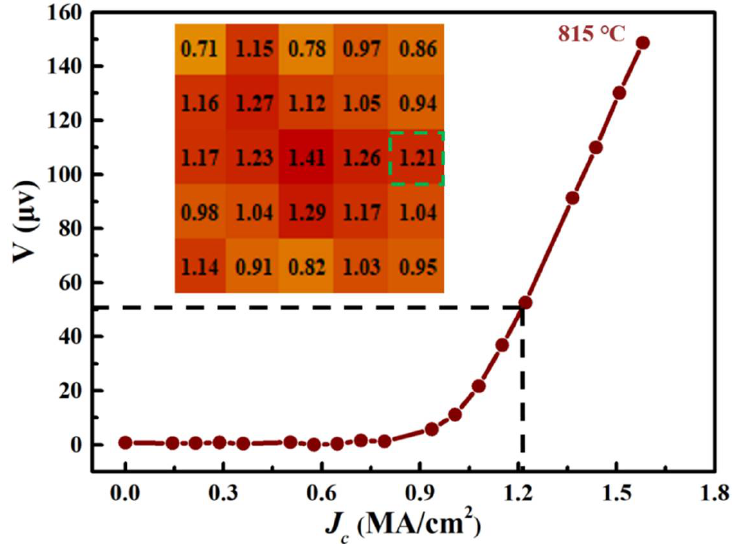
Figure 11. Scan- J c analysis on the middle of YBCO film after 30 min high-temperature treatment at 815 °C for low-vacuum pyrolysis film. Inset is the J c distribution diagram. The green box is J c curve.